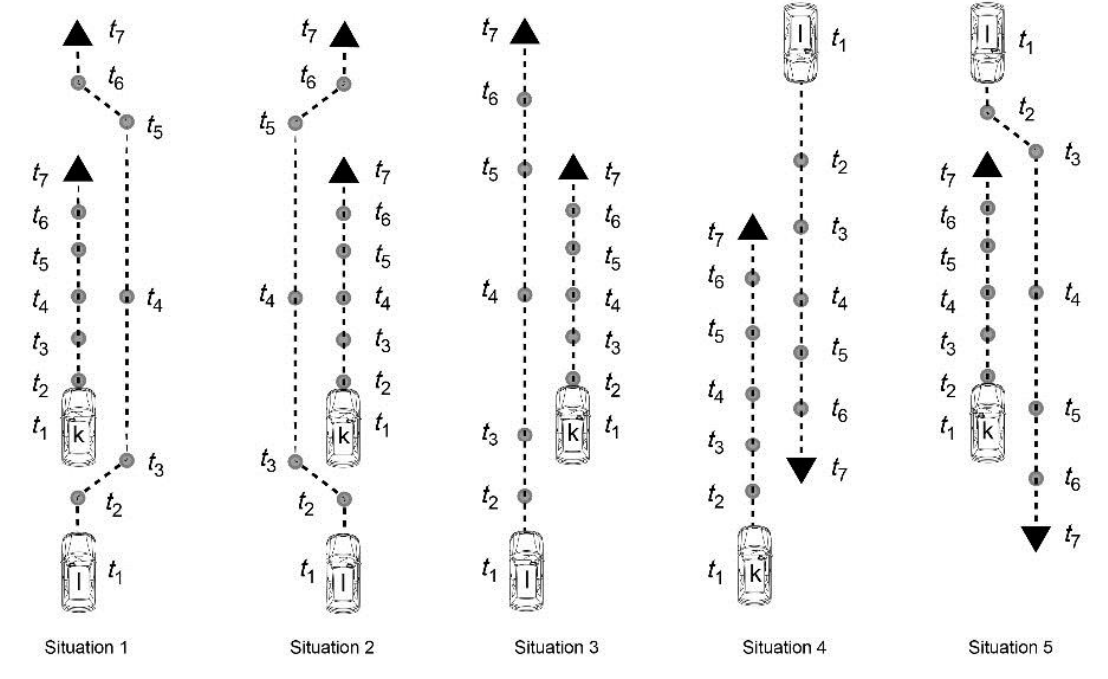
Figure 7. Five traffic situations.